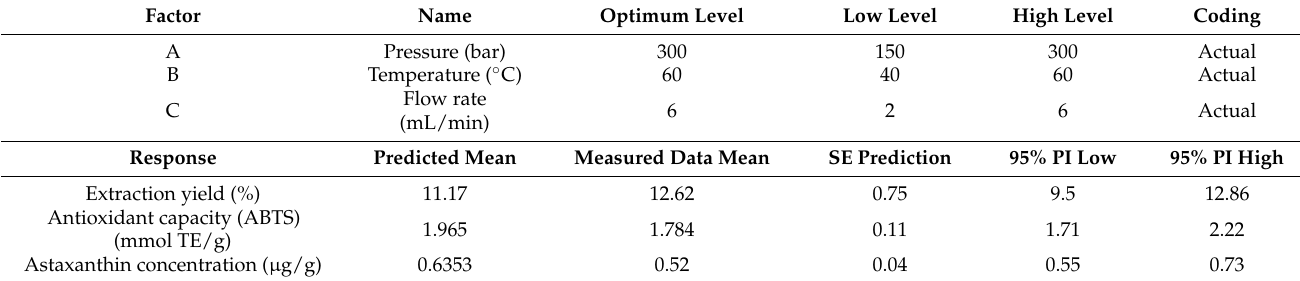
Table 2. Confirmation report of CO 2 supercritical extraction of lyophilized